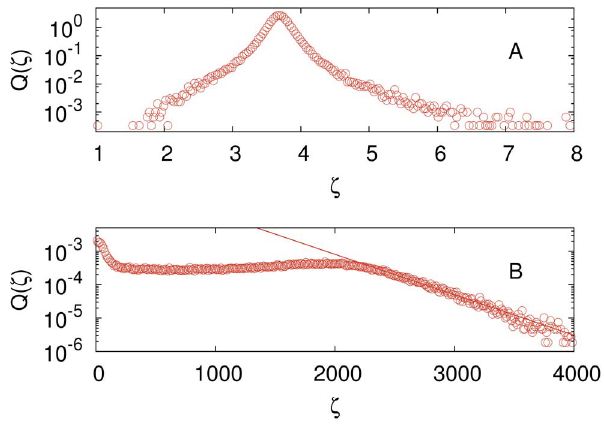
Figure 5. Probability distribution of the mean duration of the stases in a search. Probability distribution of the mean number of trials f for which a cost value stays as the lowest cost among the N solutions in 10 5 searches for the imitation probability p ~ 0 : 6 in a fully connected system. Panel A : N ~ 6 (low computational cost regime). Panel B : N ~ 17 (high computational cost regime). The slope of the straight line shown in the semi-log scale of panel B is 0 : 003 . The influence network size is M ~ N { 1 .